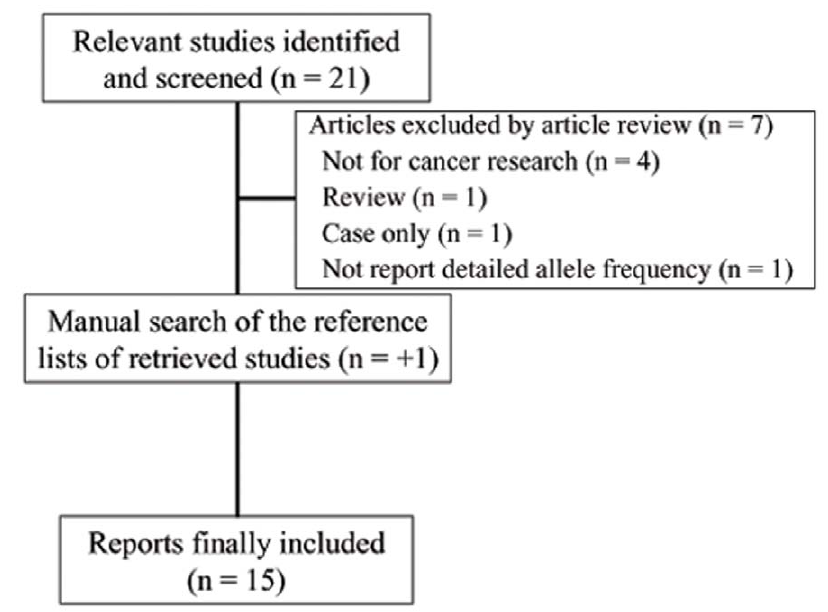
Figure 1. Studies identified with criteria for inclusion and exclusion.